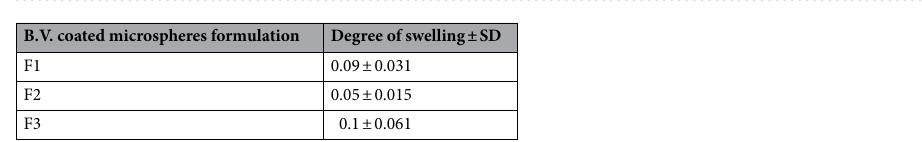
Table 2. Degree of swelling of different B.V-cross-linked chitosan coated